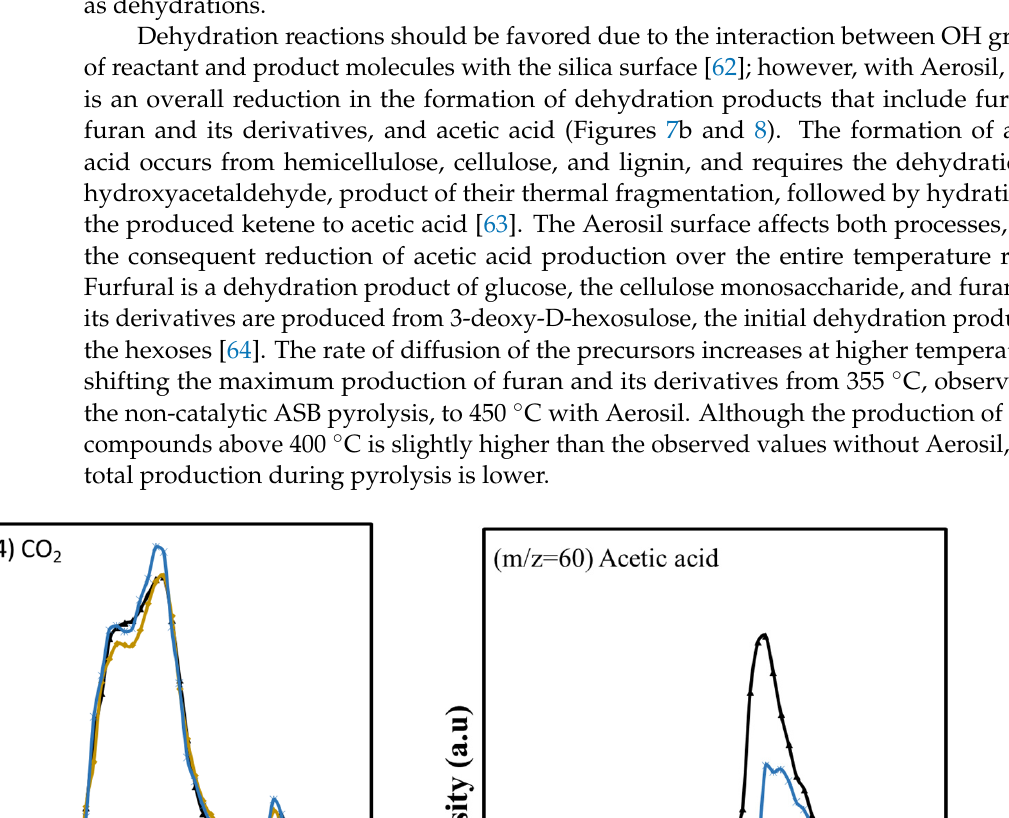
Catalysts 2023 , 13 , x FOR PEER REVIEW